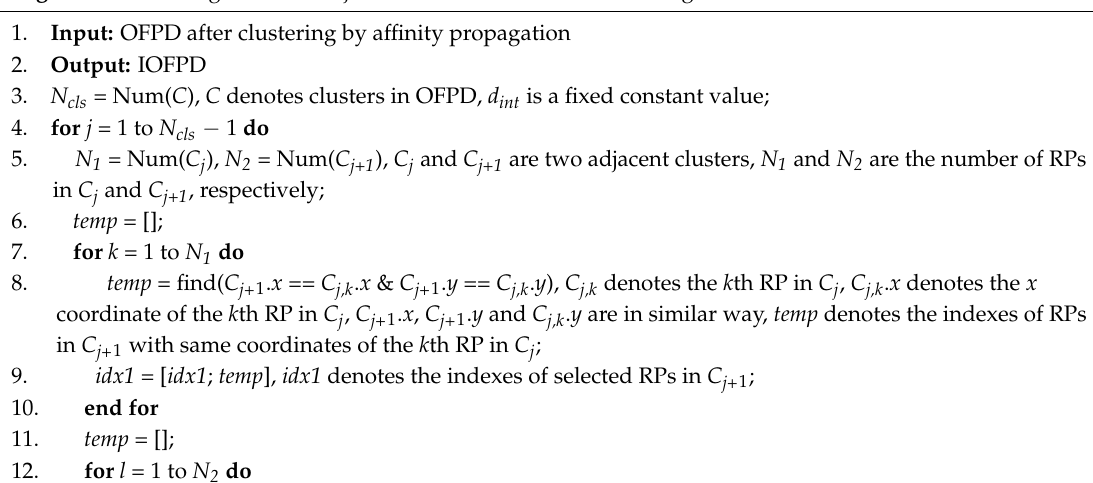
Algorithm 1: The algorithm to adjust clusters based on transition